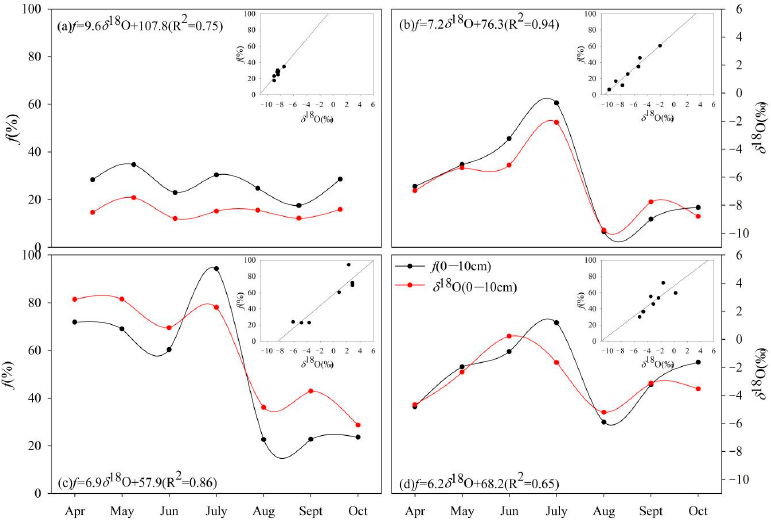
Figure 10. Changes of δ 18 O and evaporation loss f in 0 to 10 cm soil water at the four stations during the observation period (( a ) Lenglong; ( b ) Ningchan; ( c ) Huajian; ( d ) Xiying).